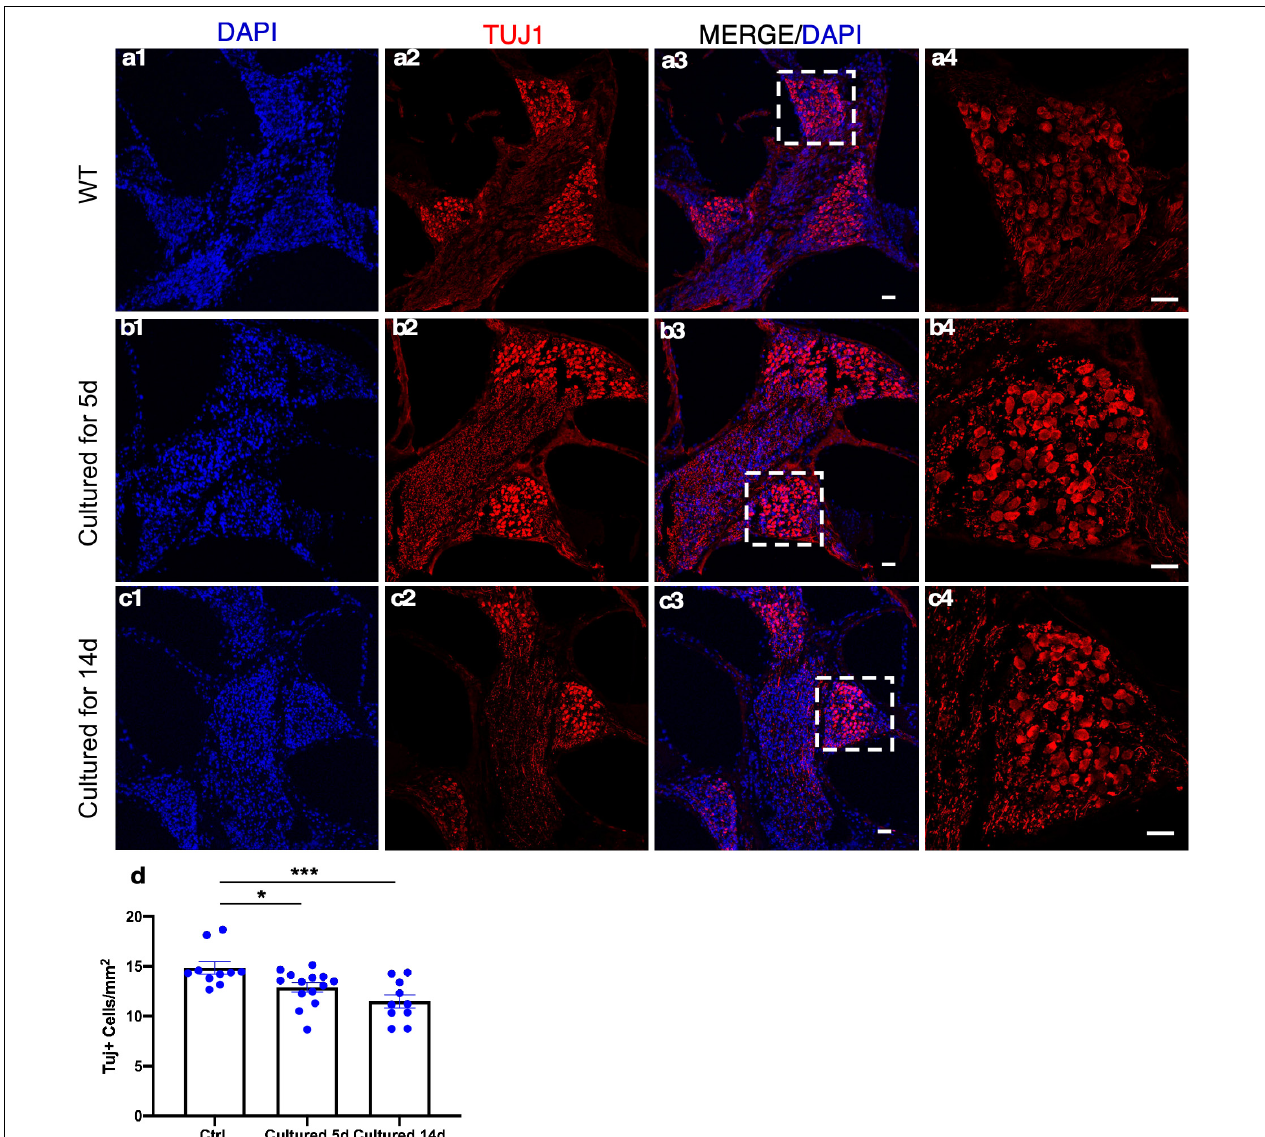
FIGURE 7 | Spiral ganglion neurons (SGNs) survive in adult cochlear explant culture. (a1–a4) In the freshly dissected adult cochleae, SGNs in the modiolus were detected by TUJ1 labeling. After 5 (b1–b4) or 14 days (c1–c4) in culture, abundant TUJ1 + SGNs were seen in the modiolus with a well-maintained structure. (d) Quantification showed the survival of a majority of adult SGNs in the apical turn even after 14 days in culture. * p < 0.05, *** p < 0.001, and one-way ANOVA comparison of the mean of each column with the mean of a control column. Error bar, mean ± SEM, and n = 10–14. n is the number of biologically independent cochlea samples. Scale bars: 25 µ